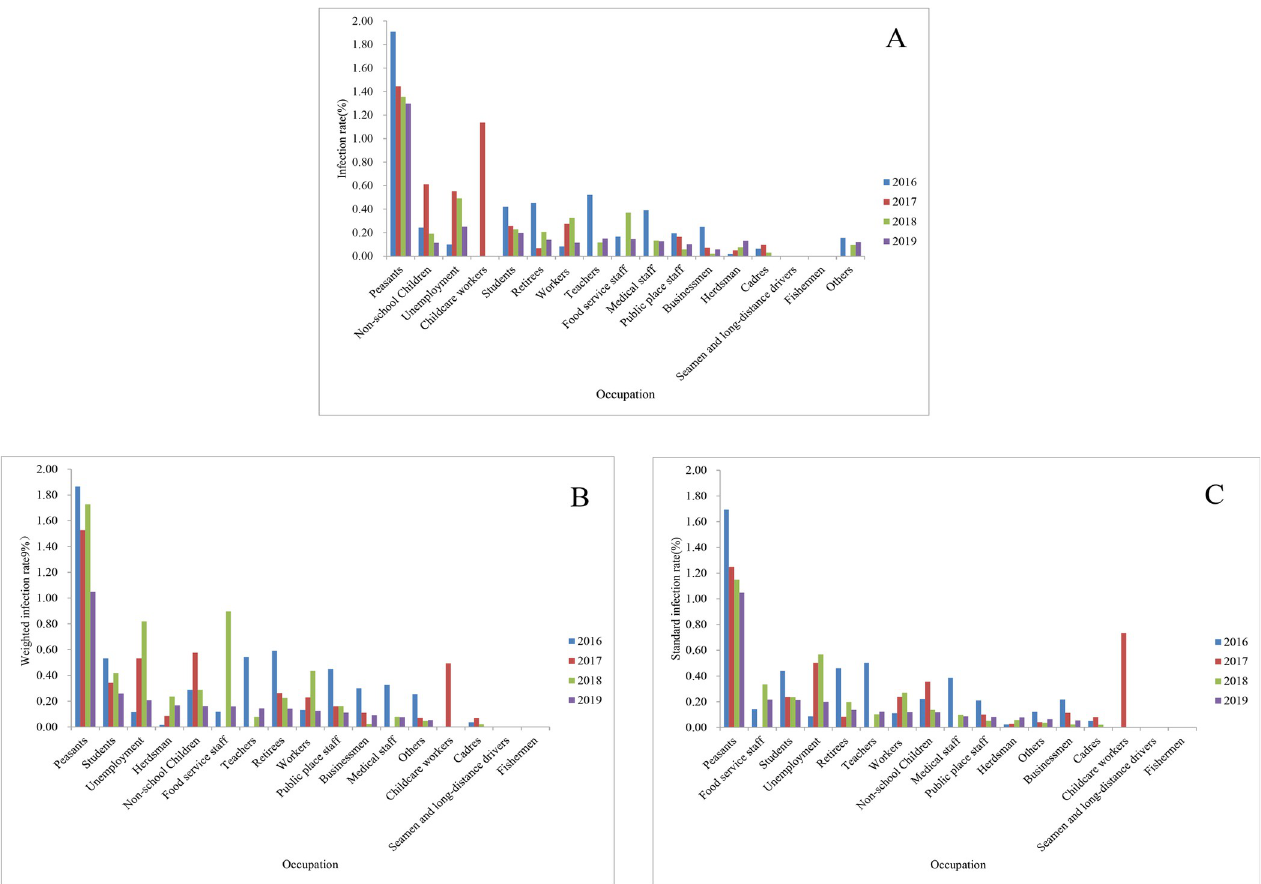
Fig 7. Occupation distribution of hookworm infections from 2016 to 2019 according to the national surveillance. A. Infection rate; B. Weighted infection rate; C. Standard infection